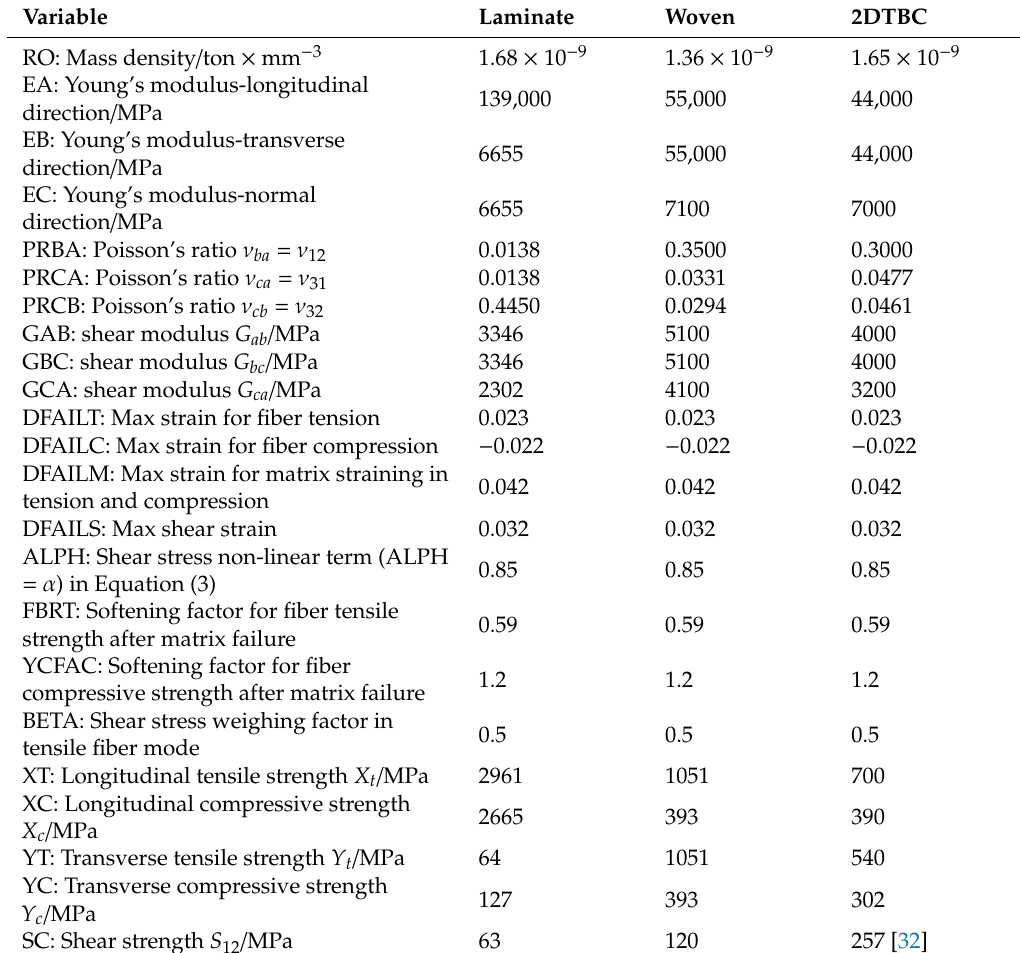
Table 3. Model parameters of MAT54 for the three types of